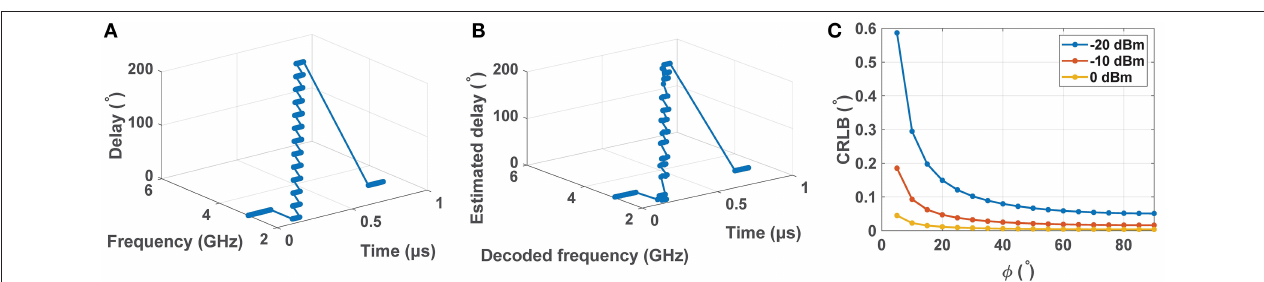
FIGURE 6 | Simulation showing tracking of a rapidly moving source with frequencies and ITDs increasing from 2 to 5 GHz and 0 to π rad, respectively: (A) actual trajectory, and (B) estimated trajectory for SNR = 20 dB. (C) Calculated Cramer–Rao lower bound (CRLB) for the angle of arrival (AOA) estimation (in degrees) at 3 GHz as a function of source position φ for various input power